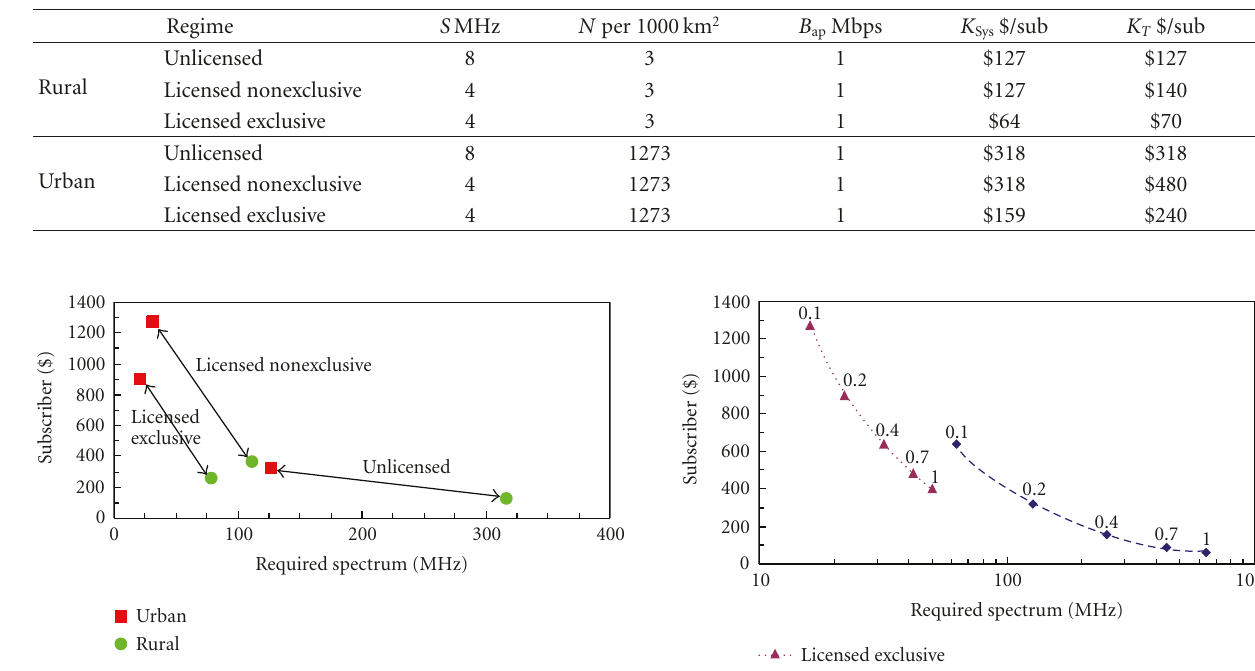
Table 6: Spectrum requirements and cost of a startup system.